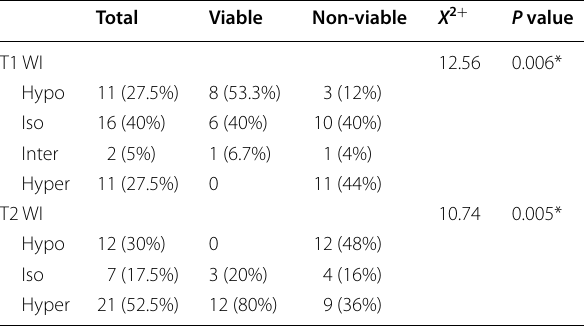
Table 2 T1 WI and T2 WI signals of radiofrequency-ablated HCC Table 3 ADC values among viable and non-viable post-RFA